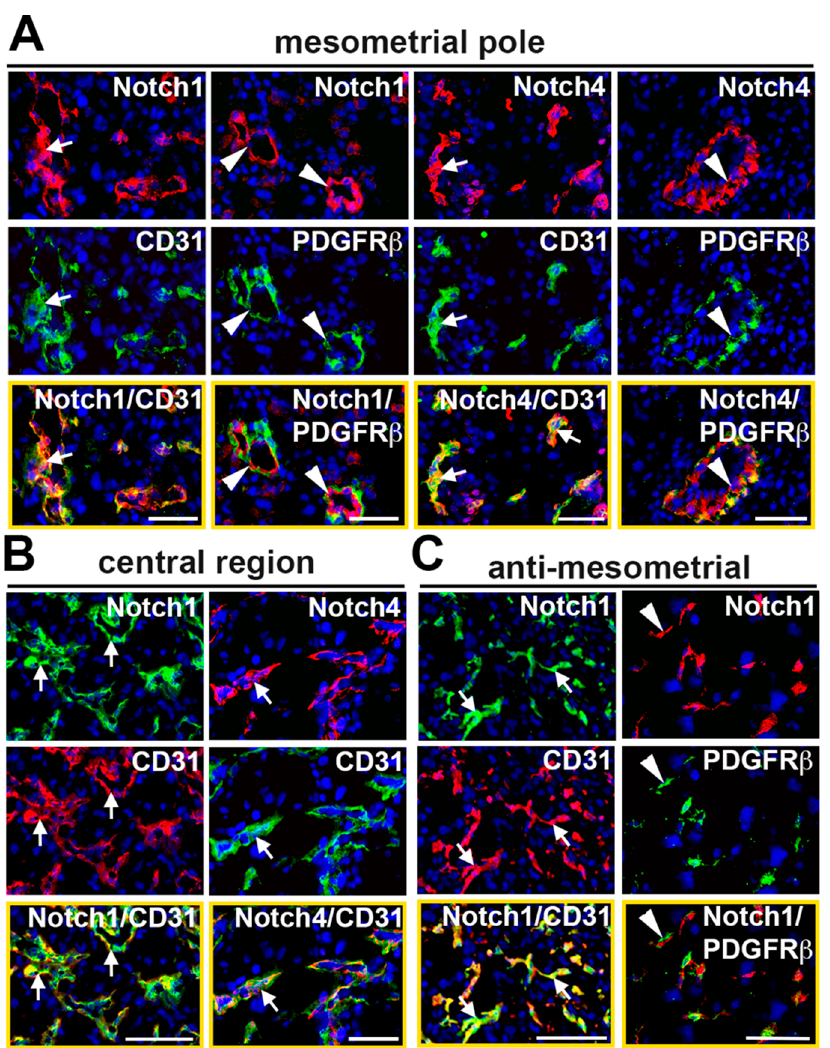
Figure 2. Expression of receptors, Notch1 and Notch4, in the E7.5 decidual vasculature. High magnification images of sections double stained to detect expression of Notch1 or Notch4 and the endothelial cell marker, CD31 or mural cell marker, PDGFR ββ . Merged images are outlined in yellow. ( A ) In the MP, Notch1 and Notch4 are expressed in CD31 + SpA ECs (white arrows). PDGFR β + mural cells are associated with both Notch1 + and Notch4 + ECs in the SpAs (white arrowheads). ( B ) In the CTR, CD31 + capillary ECs express Notch1 and Notch4 (white arrows). ( C ) In the AMR, CD31 + capillary ECs express Notch1 (white arrows) and PDGFR β + pericytes are associated with Notch1 + cells (white arrowhead). AMR = anti-mesometrial; CTR = central region; MP = mesometrial pole. Scale bars = 50 µ μ m.